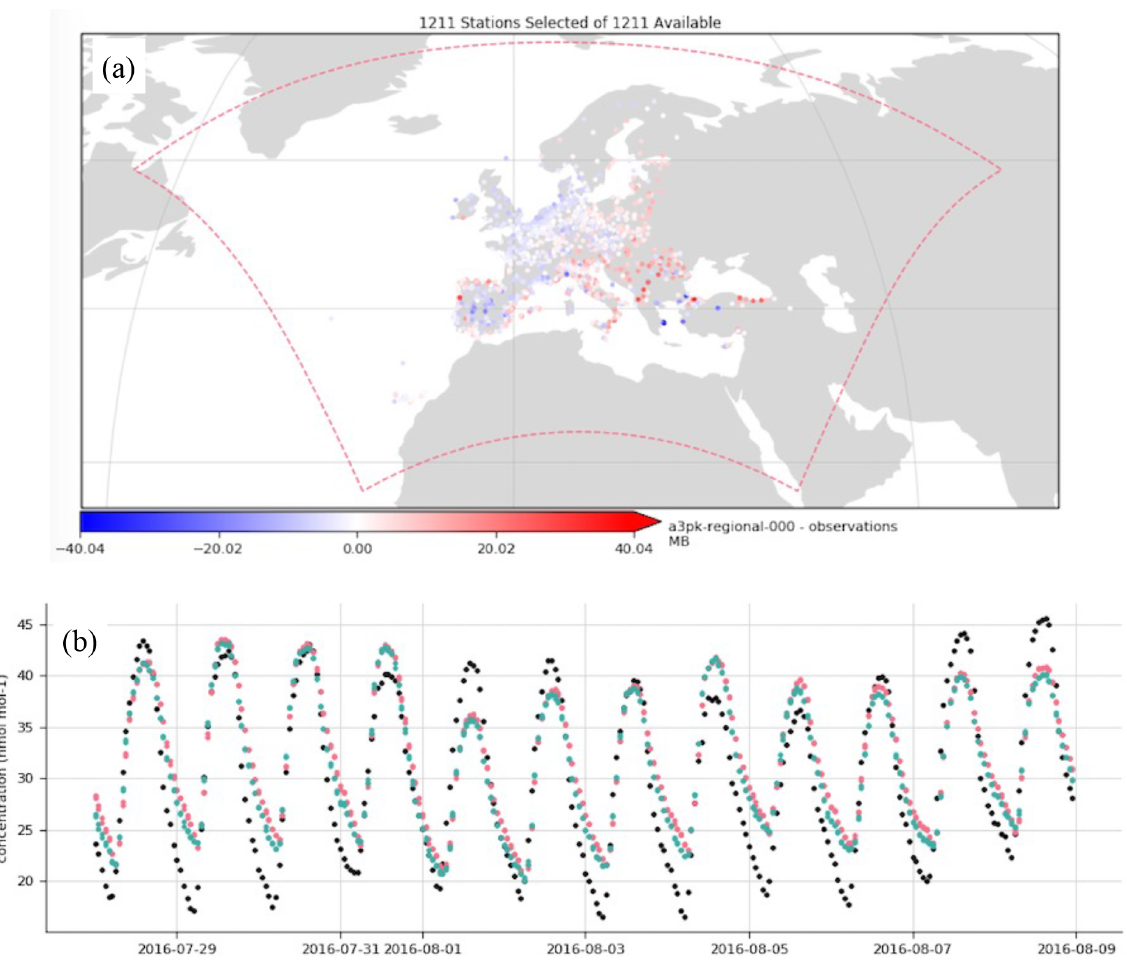
Figure 11. Evaluation of ozone surface concentration [ppbv] at the European Environment Agency (EEA) measurement sites: (a) mean bias at rural and urban background EEA sites below 1000m above sea level for the period 28 July to 9 August 2016; (b) time series of ozone concentrations averaged over EEA sites (black dots: observations, green dots: MONARCH–CAMP results, red dots: original MONARCH